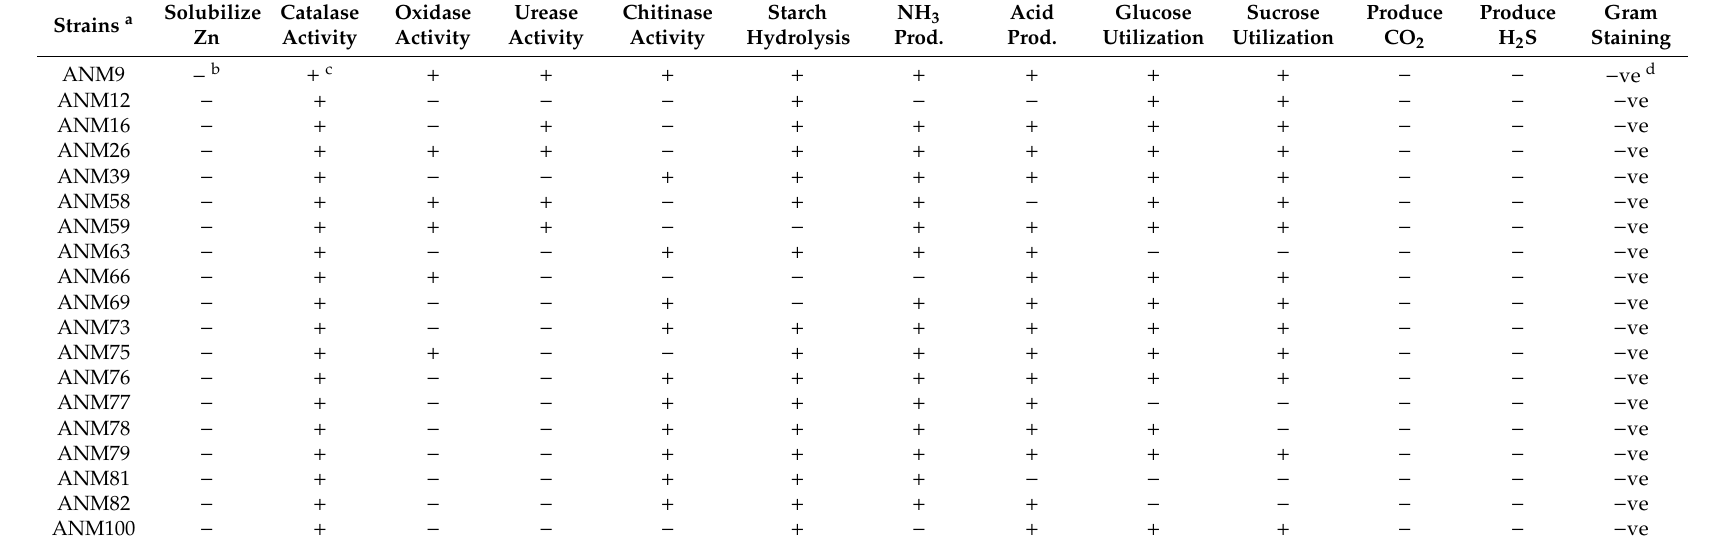
Table 2. Plant growth promoting characteristics of endophytic strains from